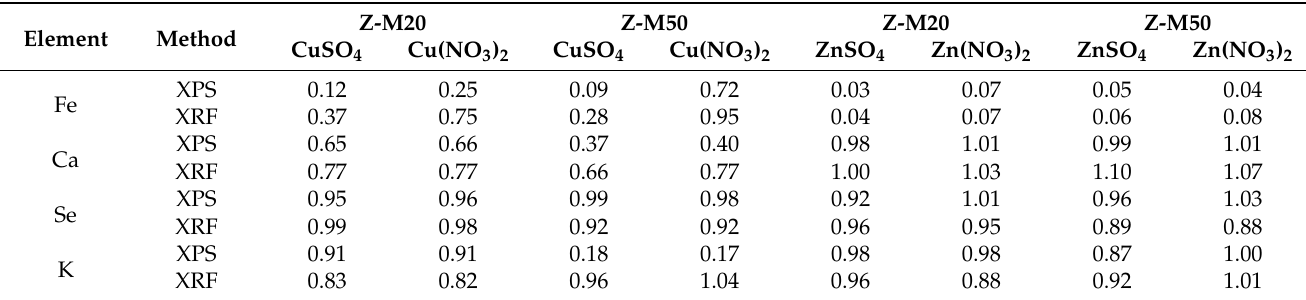
Table 7. A comparison of elemental content after: before sorption ratio.